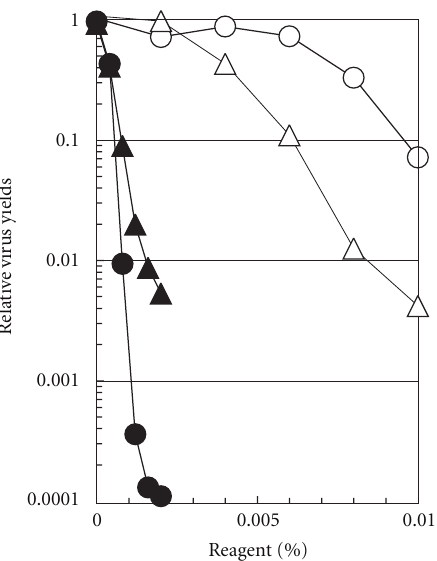
Figure 7: E ff ect of CAE and BKC on the virus multiplication. Confluent monolayers of HEp-2 cells were infected with HSV-1 ( (cid:4) , • ) at an MOI of 14 or PV-1 ( (cid:5) , (cid:3) ) at an MOI of 9. The infected cells were incubated for overnight in the medium containing varying concentrations of CAE ( (cid:4) , (cid:5) ) or BKC ( • , (cid:3) ) at 37 ◦ C for HSV-1 or at 35.5 ◦ C for PV-1. At the end of infection (20h after infection for HSV-1 and 16 h after infection for PV-1), the amounts of infectious progeny viruses were determined and were normalized to the virus yield in the absence of these